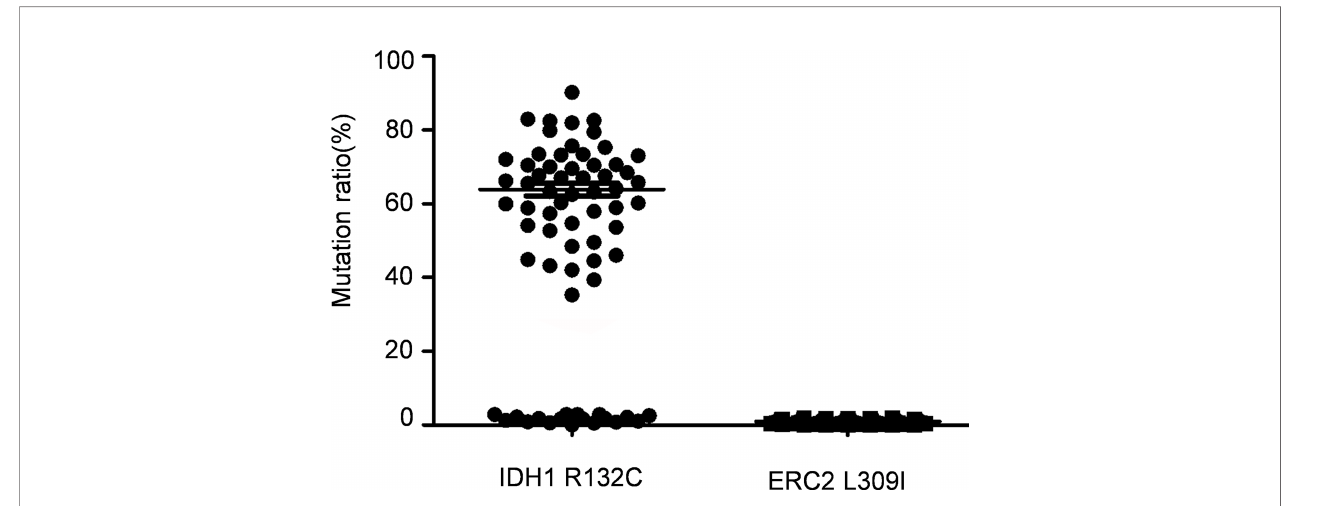
FIGURE 4 | The IDH1 R132C mutation is in Ollier disease, while the ERC2 L309I mutation is absent. The IDH1 R132C mutation was detected in most of the patients with Ollier disease (51/69 patients), and the mean frequency of this mutation was 63.3% in total sequence readouts, but the ECR2 L309I mutation was absent in all patients with Ollier disease